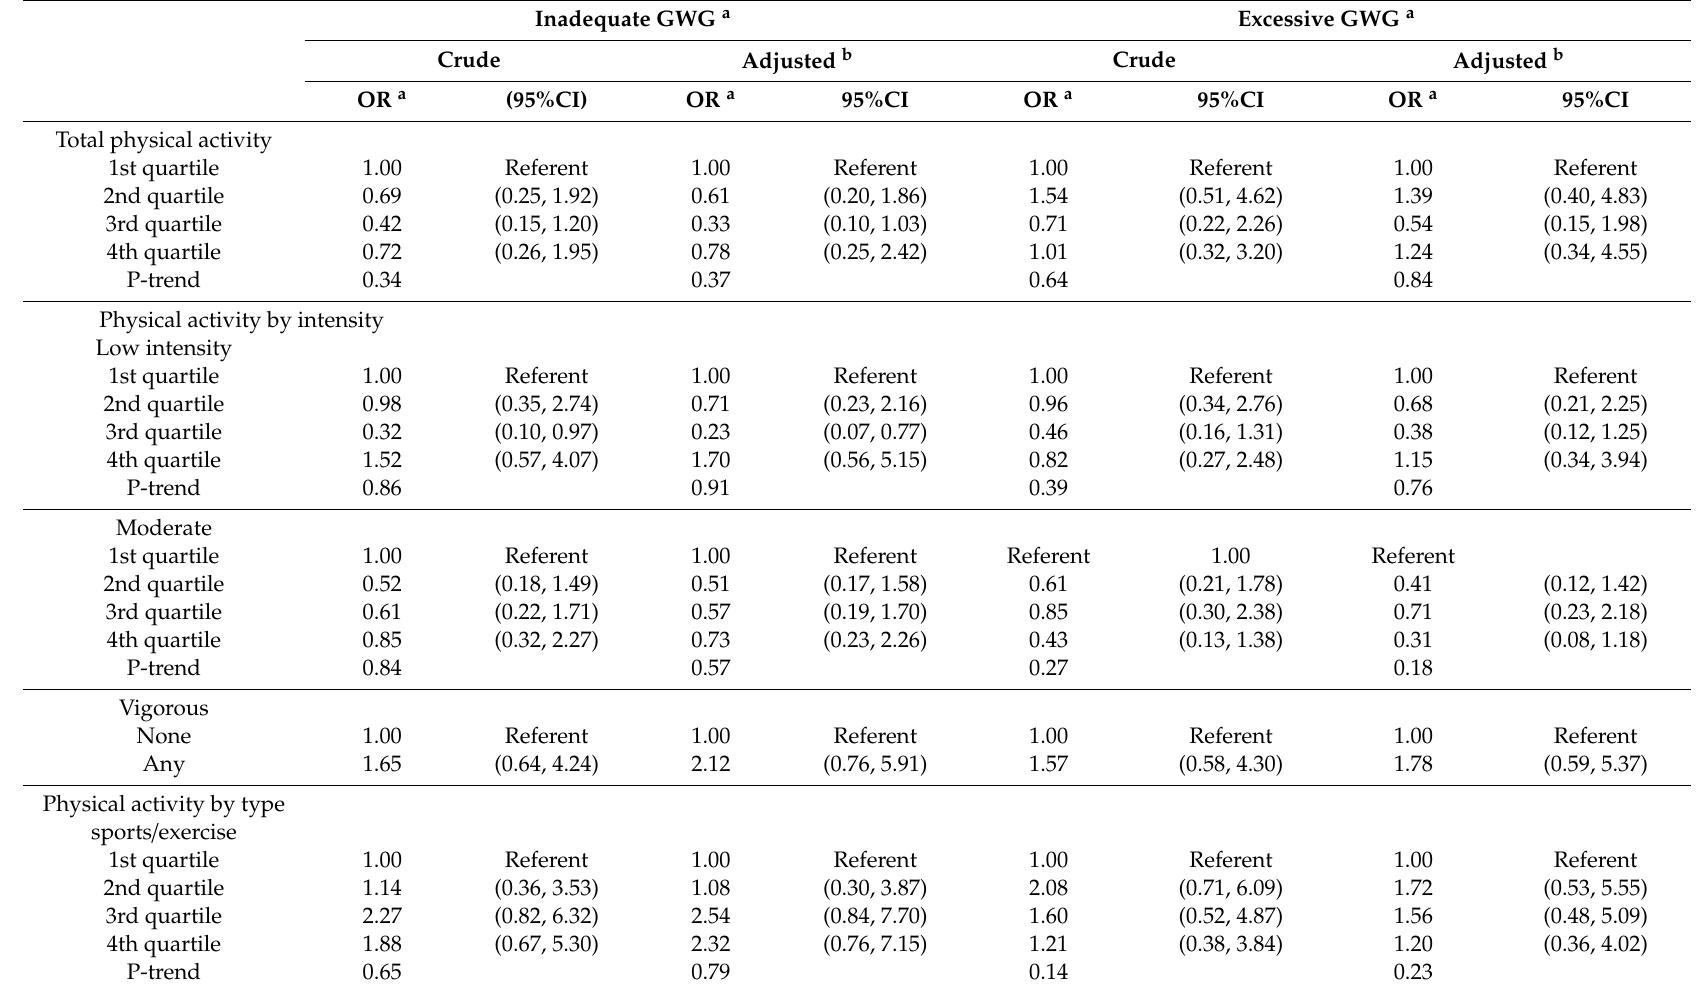
Table 2. The association between first trimester physical activity and gestational weight gain (GWG)